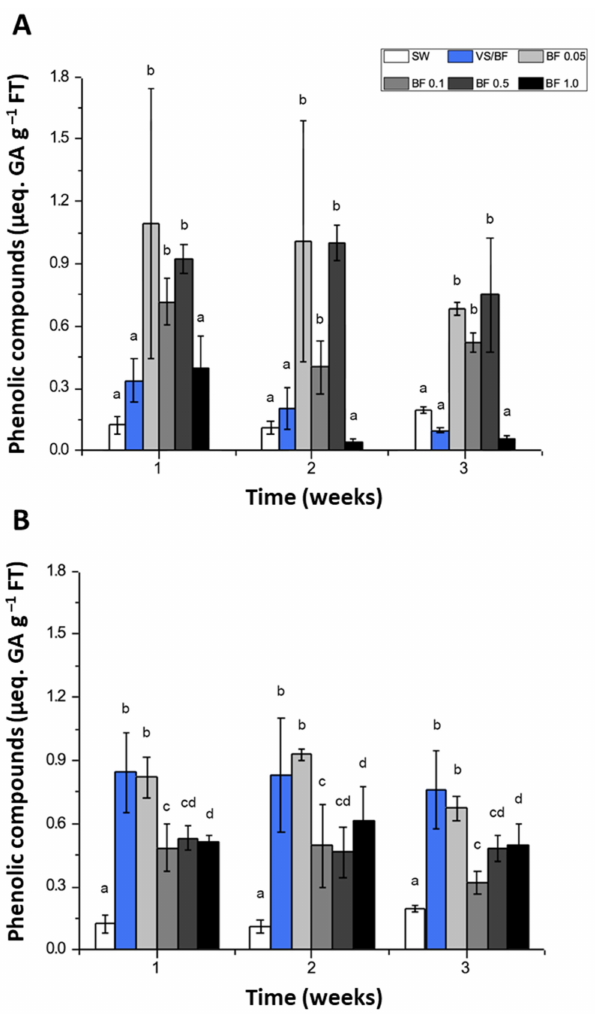
Figure 4. Phenolic compound concentration ( µ eq. GA g –1 FT, fresh tissue) in G. chilensis obtained under ( A ) indoor and ( B ) outdoor cultivation systems for each treatment evaluated (seawater (SW) treatment or control, Von Stosch/Basfoliar ® Aktiv (VS/BF) treatment, and Basfoliar ® Aktiv (0.05%, 0.1%, 0.5%, and 1% v / v ) treatments) during the three weeks of the experimental period. Values are the mean ± SD of three replicates. The letters above the bar plots indicate the results of Dunn ´ s tests; means with the same letter are not significantly different at p ≥